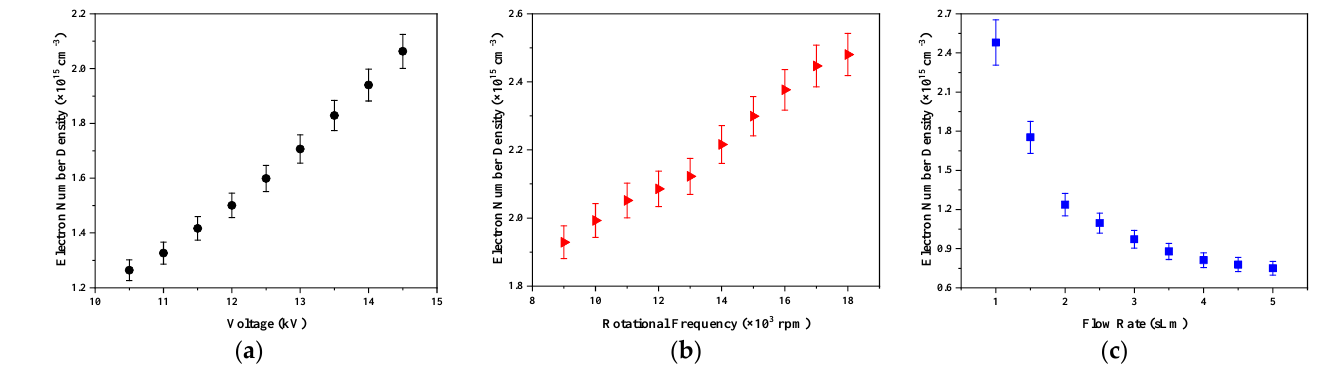
Figure 15. Variations of the electron number density in terms of ( a ) different voltages applied on the stationary power electrode at 1 sLm gas flow rate (1% error), ( b ) rotational frequencies of power electrode at 14 kV applied voltage and 1 sLm gas flow rate (1% error), and ( c ) gas flow rates at 14 kV applied voltage and 18,000 rpm rotation frequency of the power electrode (2% error).